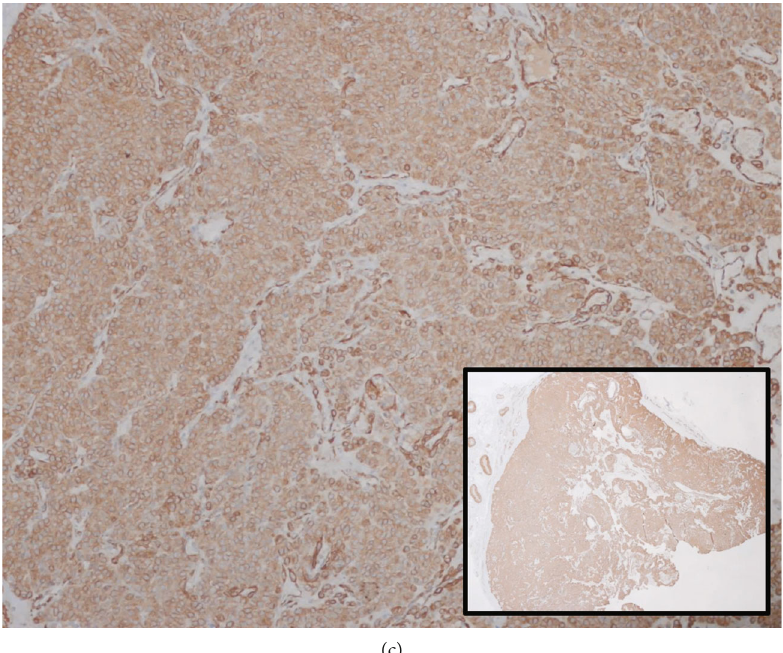
Figure 5: Histological images of the removed tumor. (a) Well-limited proliferative lesion, with a rich vascular network (hematoxylin-eosin; original magni fi cation × 20). (b) Tumor formed by ovoid, epithelial cells, without signs of atypia and showing no mitoses (hematoxylin-eosin; original magni fi cation × 40). (c) Di ff use expression of smooth muscle actin (alpha-SMA) in the tumor (immunohistochemcial staining; original magni fi cation × 20 (right inferior corner photomicrograph) and original magni fi cation × 100 (larger